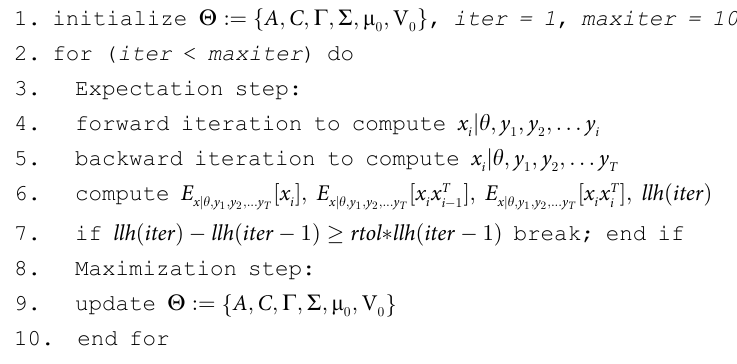
Algorithm 1. Plain version of training the LDS model on one